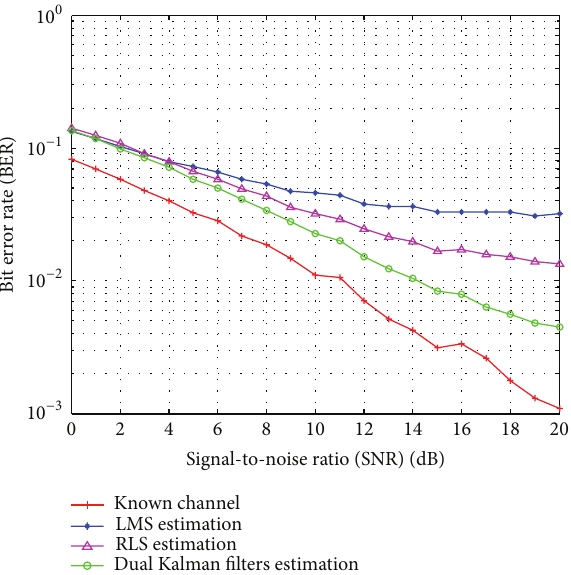
Figure 5: Envelope of estimated fading process using the various estimators. SNR = 15 dB, 𝑀 = 2048 , 𝑁 𝑝 = 1024 , and 𝑓 𝑑 𝑇 𝑠 = 0.0167 .